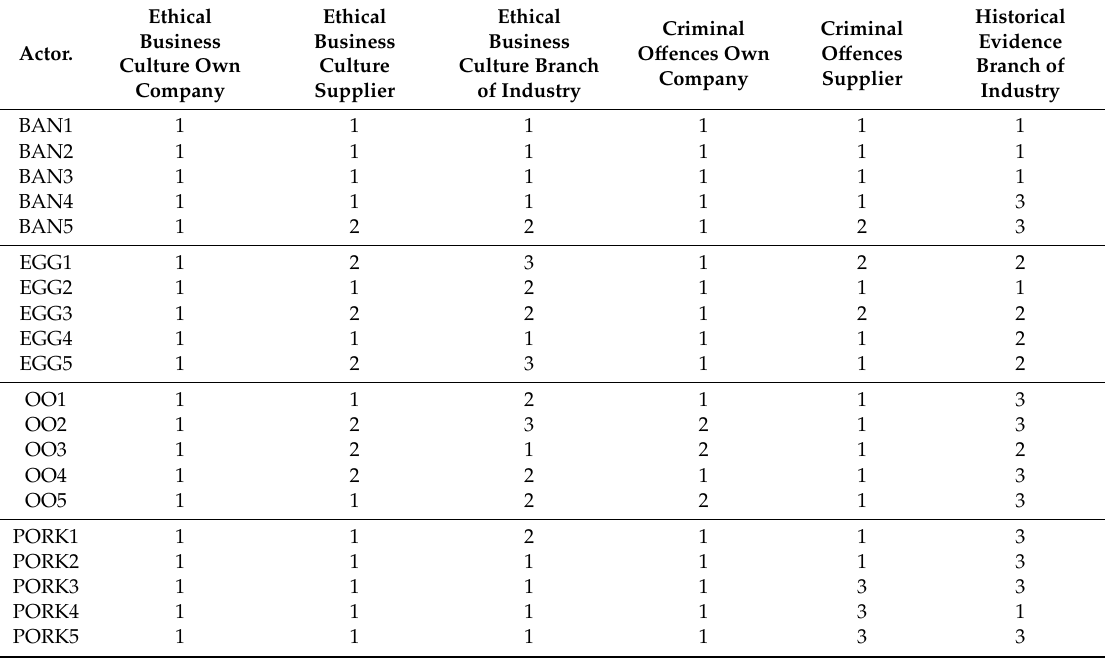
1 Scores indicate vulnerability levels of answers provided by the actors: 1 = low, 2 = medium, 3 = high. Actors are indicated by their supply chain code followed by a number (e.g., BAN1): BAN = organic bananas, EGG = organic eggs, OO = organic olive oil, PORK = organic